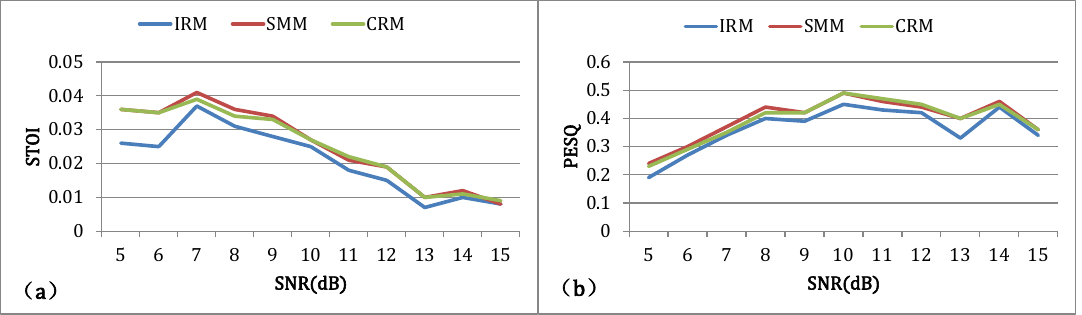
Figure 4. Gain of ( a ) STOI and ( b ) PESQ: Echo-removed speech compared to those unprocessed.